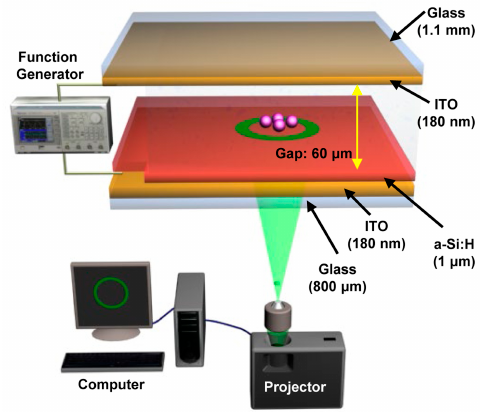
Figure 1. Schematic illustration of optoelectrokinetics (OEK) chip (reproduced from Ref. [42]).